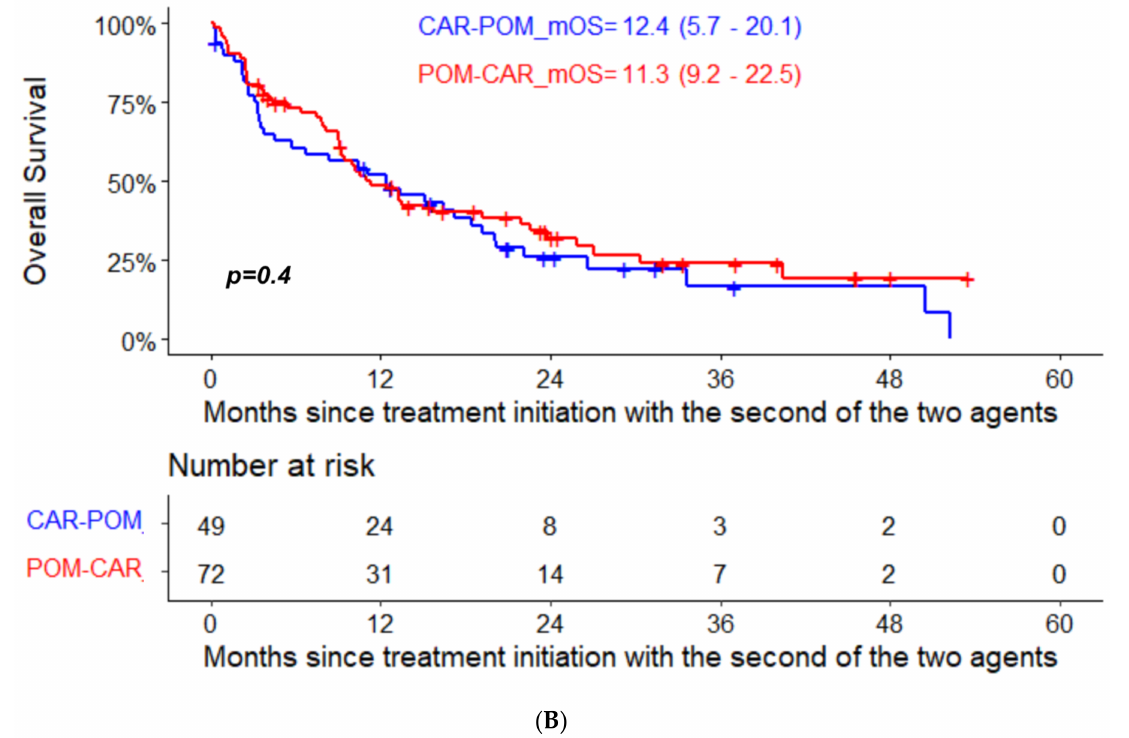
Figure 1. ( A ) PFS and ( B ) OS analysis from treatment initiation with the second of the two agents in the two groups.